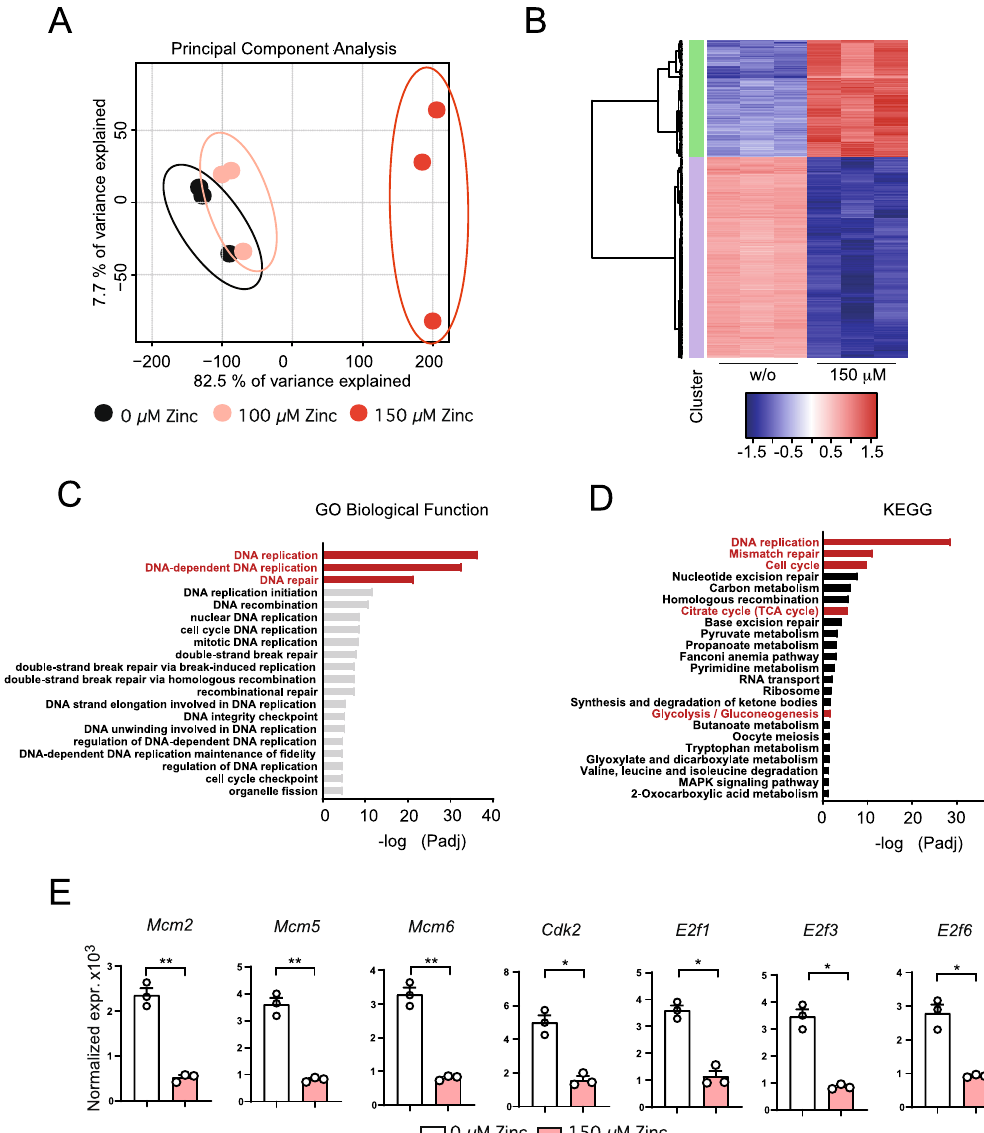
Figure 1. High dose zinc aspartate negatively regulates genes controlling cell cycle entry and progression in CD4 + T cells. ( A ) Principal component analysis (PCA) of the individual biological samples used for bulk RNA sequencing. ( B ) Unsupervised clustering heatmap showing differentially expressed genes (DEG) between individual biological samples. ( C ) TOP Gene ontology (GO) Biology Function pathways based on p-value. Shown is the –log 10 of the p-values of the individual pathways. ( D ) TOP KEGG pathways based on p-value. Shown is the –log 10 of the p-values of the individual pathways. ( E ) Normalized gene expression of Mcm2 , Mcm5 , Mcm6 , Cdk2 , E2f1 , E2f3 , and E2f6 determined by RNA sequencing. Statistical analysis in ( E ) by unpaired student’s t test. Dots represent individual mice used to isolate OT-II TCR tg CD4 + T cells. RNA sequencing data was generated in biological triplicates from 3 mice. KEGG was used for pathway analysis 26 . p* < 0.05, **p < 0.01, ***p <